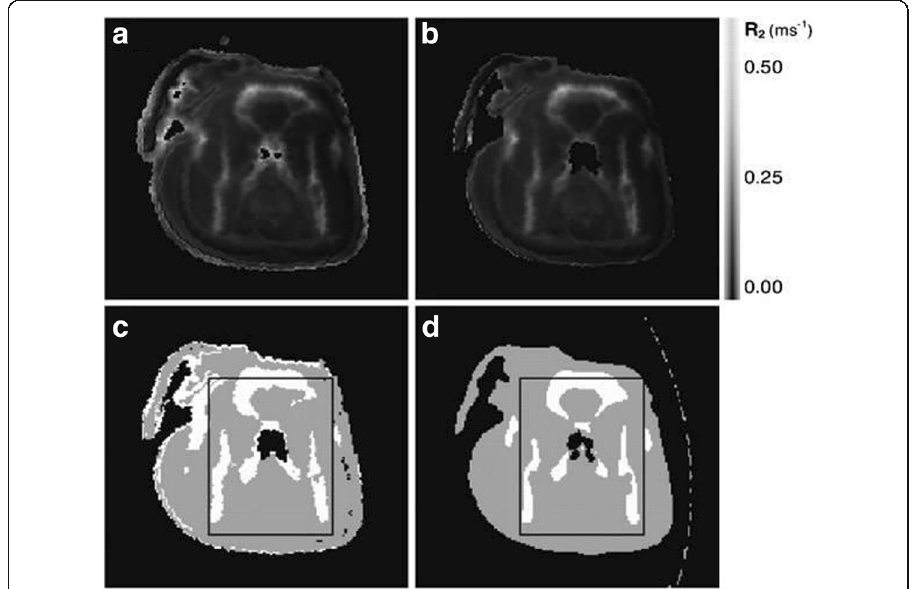
Fig. 8 Transverse slices of uncorrected ( a ) and corrected ( b ) R2 maps and segmented MR ( c ) and CT ( d ) images of phantom (This research was originally published in V. Keereman, Y. Fierens, T. Broux, Y. De Deene, M. Lonneux, and S. Vandenberghe , “ MRI-based attenuation correction for PET/MRI using ultrashort echo time sequences, (Catana et al. 2010) ” J. Nucl. Med. , vol. 51, no. 5, pp. 812 – 818, 2010.© by the Society of Nuclear Medicine and Molecular Imaging,